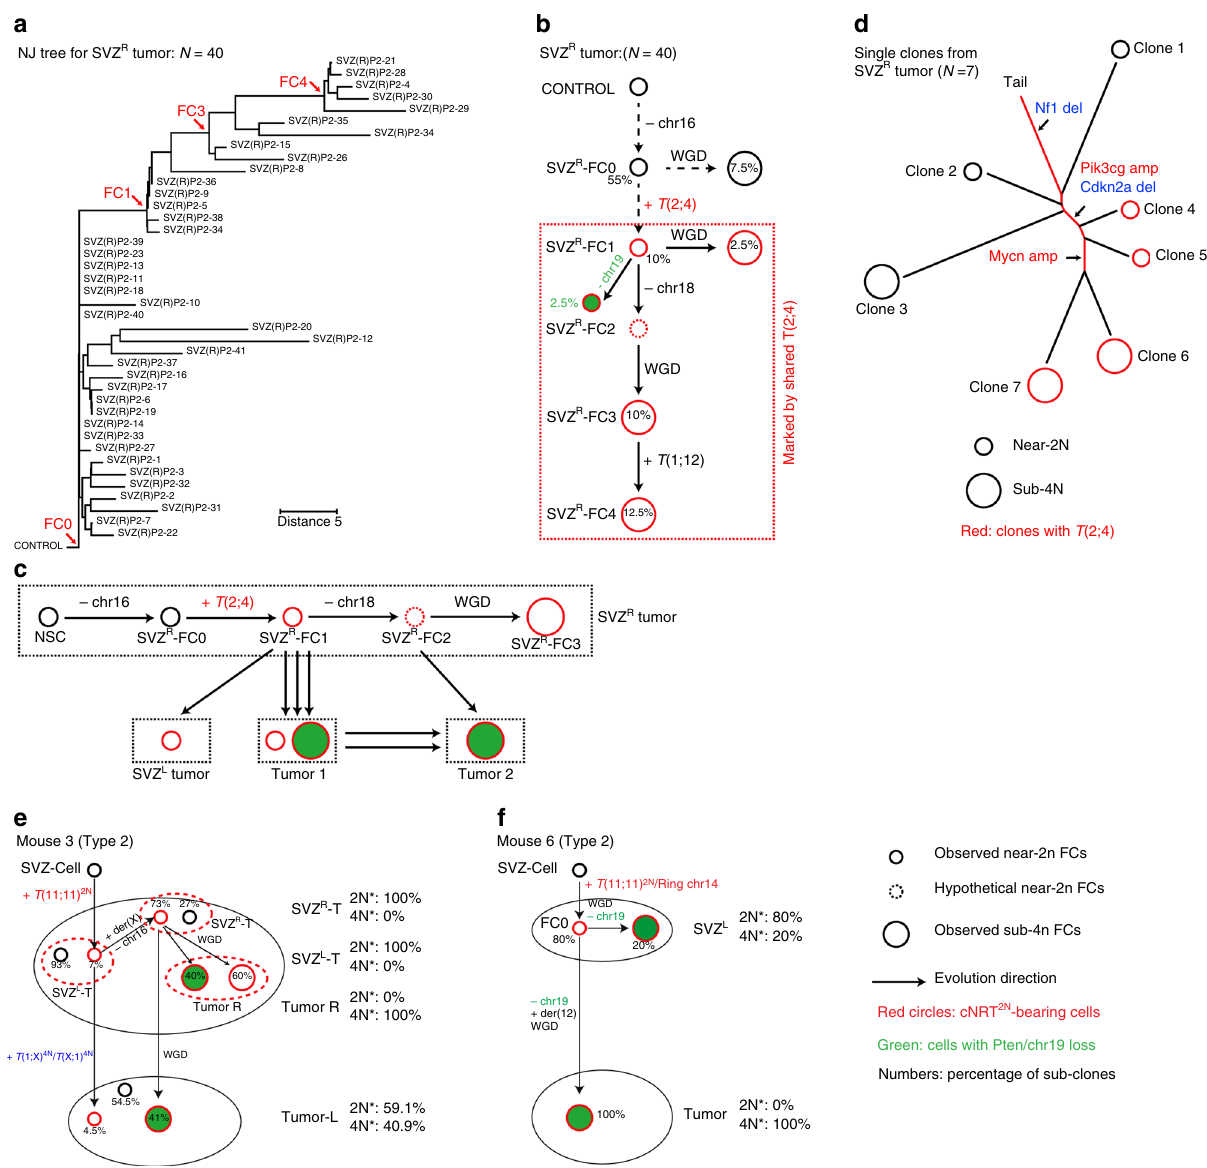
Fig. 5 Single-cell phylogenetic trees reveal the two-phase evolution pattern in Type 2 cases. a SKY-based single-cell phylogenetic tree was generated with all metaphases in Mouse 2 SVZ R -T using a neighbor-joining algorithm with customized feature and distance measure selection (see “ Methods ” for details). Red arrows indicate major clusters. b The genotype of each founder cell/clone (FC) of the major clusters on the phylogenetic trees was extrapolated based on common genetic features, and their clonal relationship was illustrated. Major chromosomal events shared by cells in each branch are shown. c A schematic model shows the mode of distant dispersal in Mouse 2 from the SVZ R to the three distant sites via parallel seeding and polyclonal seeding based on interpretation of SKY-based single-cell analysis. d WGS data of seven single-cell-derived bulk tumor samples isolated from Mouse 2 SVZ R -T were used to generate genome-wide CNV pro fi les, and a neighbor-joining tree was constructed to predict the evolutionary trajectory of these clones. Line length corresponds to difference in CNV pro fi les. Shared genetic events of known oncogenes or tumor suppressors are marked. See “ Methods ” for details. Models show a similar two-phase evolutionary pattern from the SVZ to distant brain regions in two additional Type 2 cases, Mouse 3 ( e ) and Mouse 6 ( f